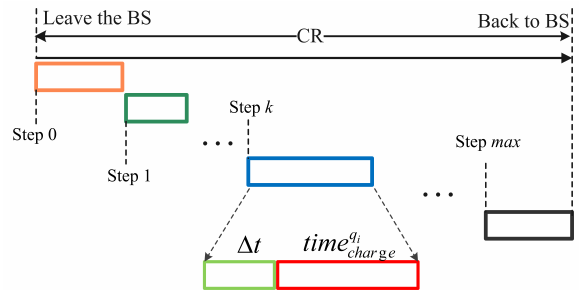
Figure 4. Charging sequence based on